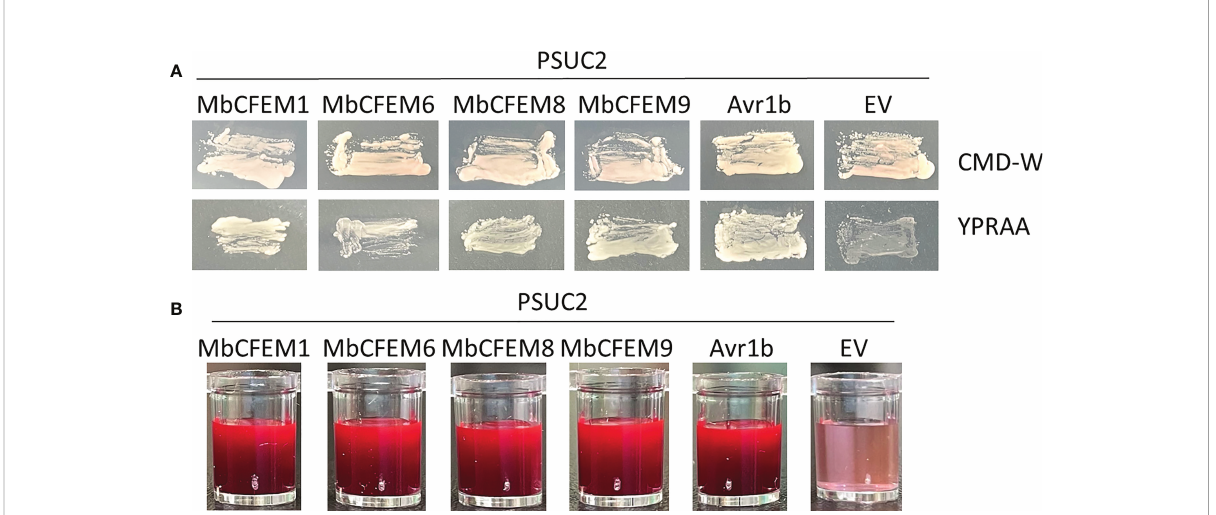
FIGURE 4 Functional evaluation of the signal peptides from four candidate MbCFEM effectors. (A) The secretion function of the predicted signal peptides was proved by employing a yeast secretion system with Saccharomyces cerevisiae strain YTK12. PSUC2 carrying signal peptides from four MbCFEM candidate effectors and the positive control Avr1b could all make YTK12 survive on CMD-W and YPRAA medium, while YTK12 containing empty PSUC2 as a negative control failed to grow on YPRAA. (B) The invertase activity was veri fi ed by the reduction of 2,3,5- triphenyltetrazolium chloride (TTC) to the insoluble, red-colored 1,3,5-triphenylformazan (TPF). PSUC2 carrying signal peptides from candidate MbCFEM effectors and the positive control Avr1b successfully turned the reaction mixture to bright and thick red while the negative control stayed pink as the